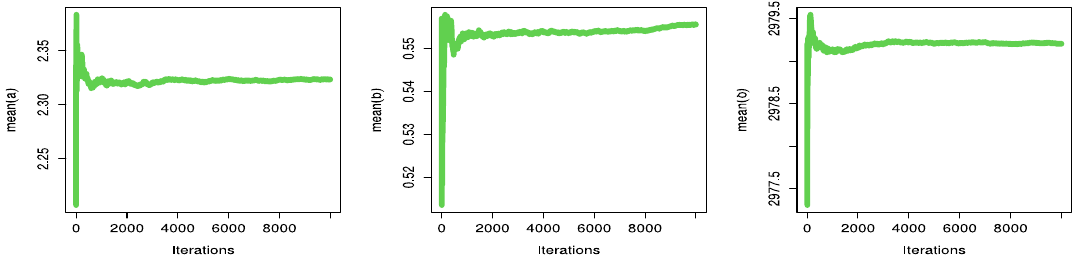
well as the parameter random draw plot, respectively.